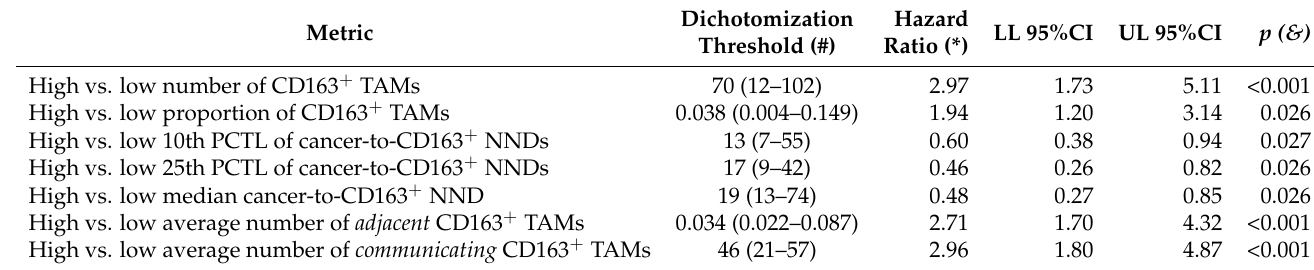
Table 2. Bias-adjusted hazard ratios and optimal cutpoints for dichotomized